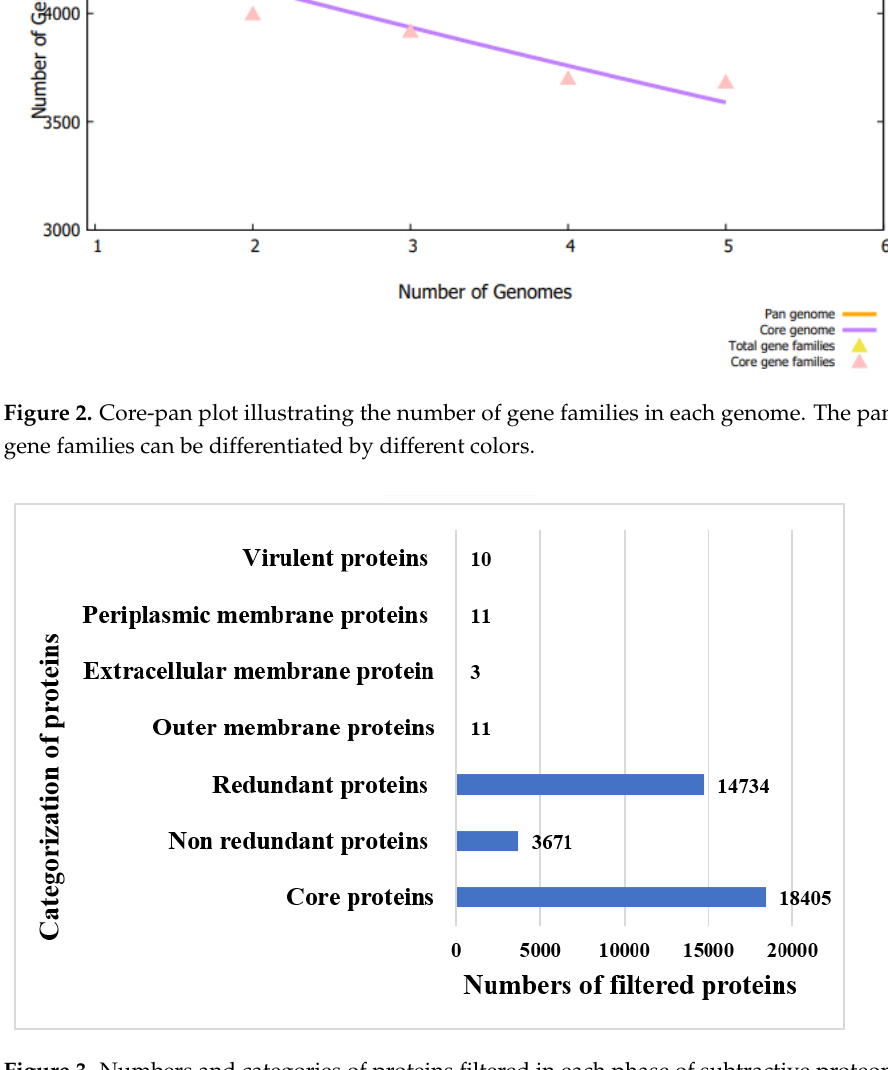
Figure 3. Numbers and categories of proteins filtered in each phase of subtractive